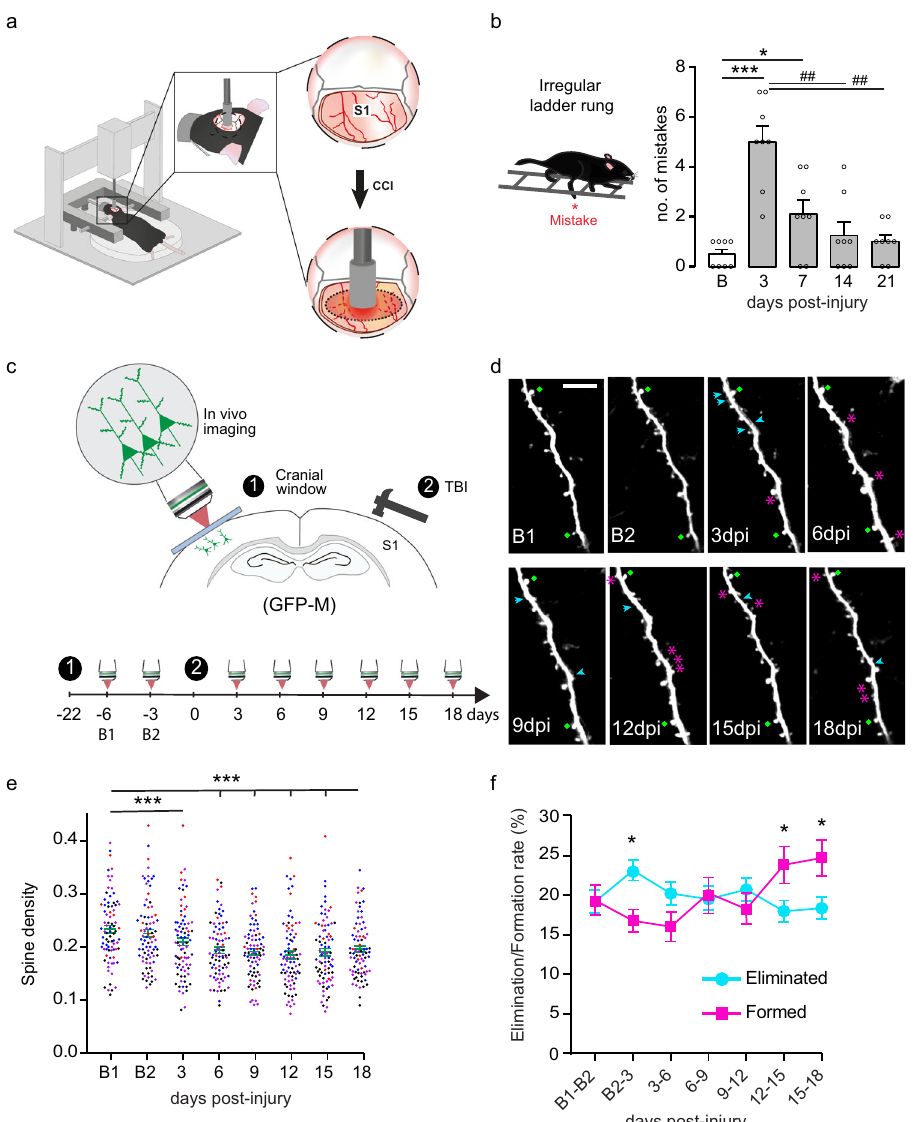
Fig. 1 Traumatic brain injury triggers a contralesional decrease in spine density and time-dependent variations of the rate of eliminated /formed spines on dendrites of GFP-M mice analyzed using two-photon in vivo imaging. a Scheme of the moderate brain injury depicting the fl at-edged impactor used to lesion the brain (S1: primary somatosensory cortex; CCI: controlled cortical impact). b Scheme of the irregular ladder rung test used to evaluate sensorimotor recovery following traumatic brain injury and quanti fi cation (mean ± SEM) of the number of mistakes at baseline and following the injury. Data are analyzed with a Friedman test followed by uncorrected Dunn ’ s test. ***: p = 0.0001 3d vs Baseline; *: p = 0.0481 7d vs Baseline; ## p = 0.0044 at 14d, 21d vs 3d. c Scheme of the experimental design and timeline of the two-photon in vivo imaging. d Representative timelapse series of an apical dendrite from a layer V neuron in GFP-M mice assessed at the indicated experimental time point and followed up to 18d post-injury. B: Baseline; Scale bar: 10 μ m. Cyan arrowhead indicates the position of a lost spine, green dot indicate stable spines present throughout the entire investigational period, and fushia asterisk indicates gained spines. e Quanti fi cation (mean ± SEM) of spine density at different time points post-injury (dendrites are color-coded per animal). Data are analyzed with one-way RM Anova followed by Dunnett ’ s test. *** p = 0.0001 3 dpi vs B1; *** p < 0.0001 6, 9, 12, 15, 18dpi vs B1. f Average of elimination and formation rate of spines in GFP-M mice. Data in ( e and f ) come from 81 dendritic stretches, 10,191 spines followed over time and n = 4 animals. Data are presented as mean ± SEM and analyzed with two-way RM Anova followed by Tukey test. * p = 0.0146 3 dpi vs B2 eliminated vs formed; * p = 0.0287 12 dpi vs 15 dpi eliminated vs formed; * p = 0.0146 15 dpi vs 18 dpi eliminated vs formed. Source data are provided as a Source Data fi le. B1: Baseline 1; B2: Baseline dendrites of callosal and non-callosal neurons (Fig. 2b – d, right spine density of distal dendritic segments of layer V callosal panels and Fig. 2e,f right panels ). We found a decrease in spine neurons (Fig. 2d, middle panel ) and could observe a signi fi cant density at 14d in layer II/III callosal neurons ( p = 0.0288) and a albeit transient decrease in spine density at 7d post-injury decrease in spine density at 7d ( p = 0.0286) and 14d ( p = 0.0288) ( p = 0.0341 One-Way Anova and Dunnett ’ s test). In contrast, in layer V callosal neurons while no such changes were observed similarly to the apical tufts, no changes in spine density could be in layer II/III and layer V non-callosal neurons (One-Way Anova seen on the distal compartment of the dendritic trunk of layer V and Dunnett ’ s test for all comparisons). Finally we examined the non-callosal neurons (Fig. 2f, middle panel ). To con fi rm that the